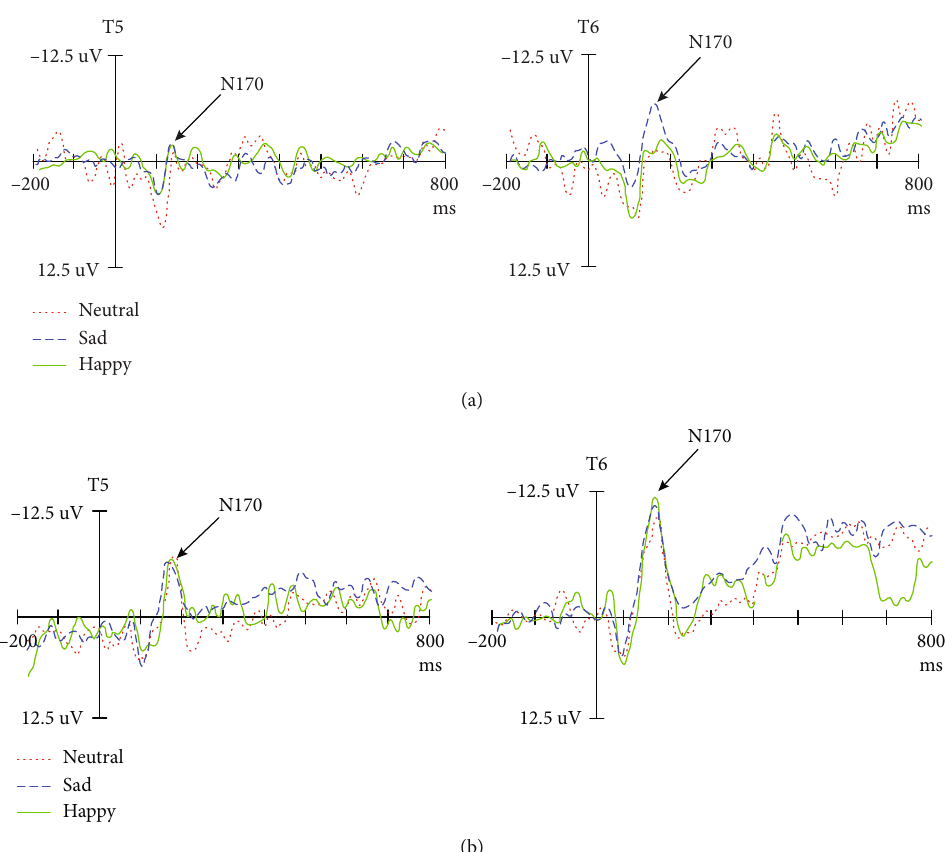
Figure 2: The wave of ERPs for facial expression category between the depressed (a) and control groups